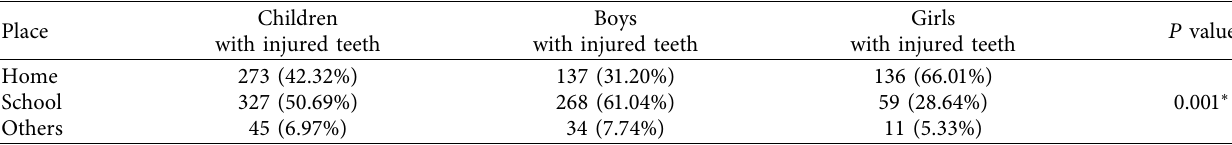
Table 5: Te distribution and percentage of children with traumatized anterior teeth according to the place of injury. Place